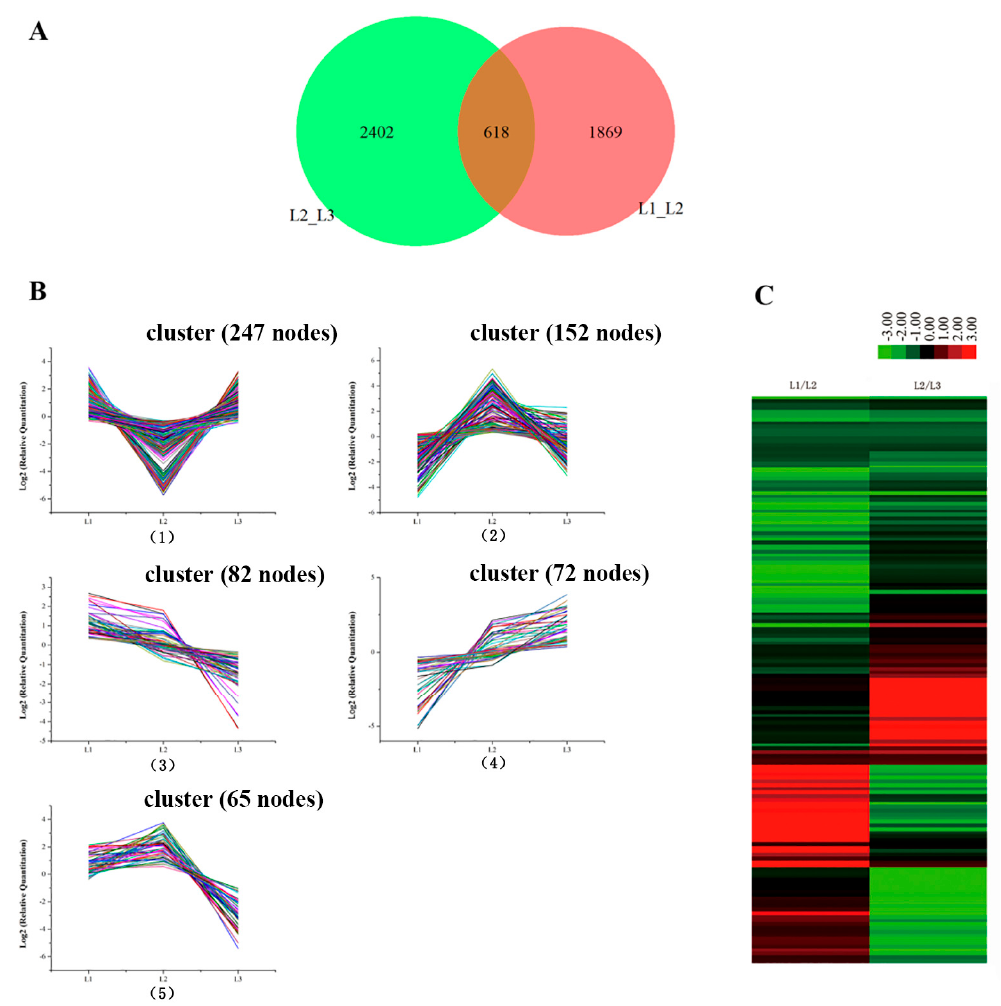
Figure 4. The differently expressed genes from L1 to L3 in the same bamboo clump. ( A ) A Venn diagram showing the number of differentially expressed genes between every two samples and the number of joint differentially expressed genes. ( B ) The clustering of differentially expressed genes. Expression ratios are expressed as Log2. The 8 major clusters obtained by the K-means algorithm, representing (1) those down-regulated at L2 and up-regulated at L3; (2) those up-regulated at L2 and down-regulated at L3; (3) those down-regulated from L1 to L3; (4) up-regulated from L1 to L3; and (5) those up-regulated at L2 and down-regulated at L3; the expression level at L3 is lower than that at L1. ( C ) Hierarchical clustering of the differentially expressed genes.